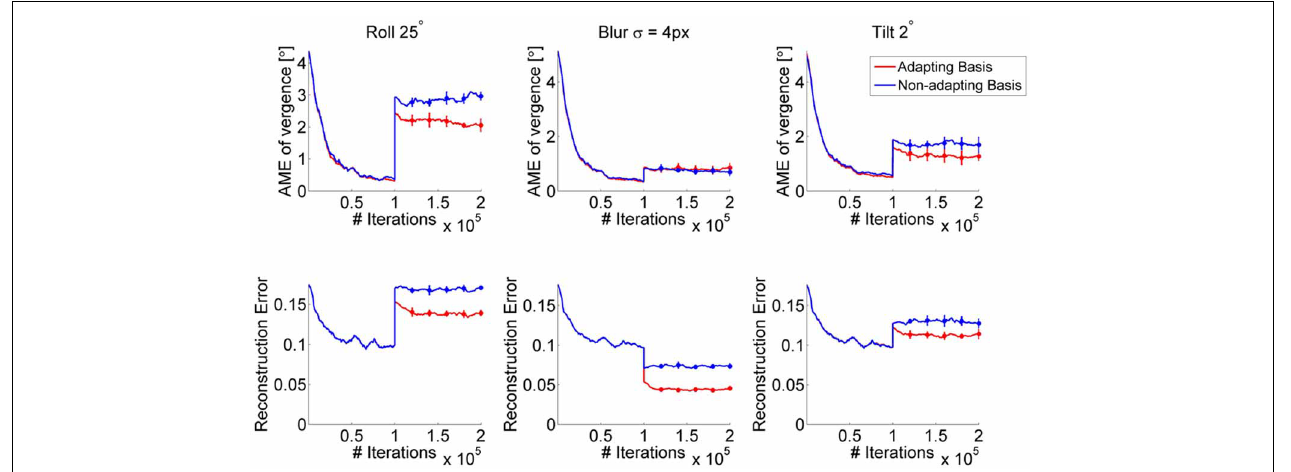
FIGURE 7 | AME (first row) and reconstruction error of the fine scale sparse coding models (bottom row) when the bases of the sparse coding models are adapted (red) vs. fixed (blue).